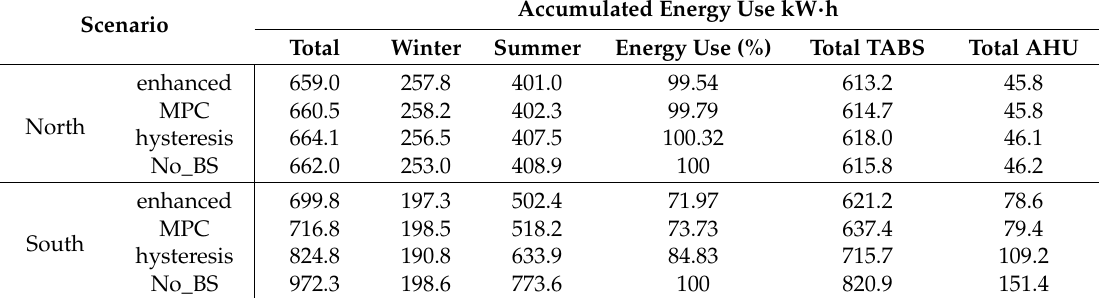
Table 6. Accumulated energy use of the HVAC system when different BSC are used. Energy use is referenced to the scenario without BS.